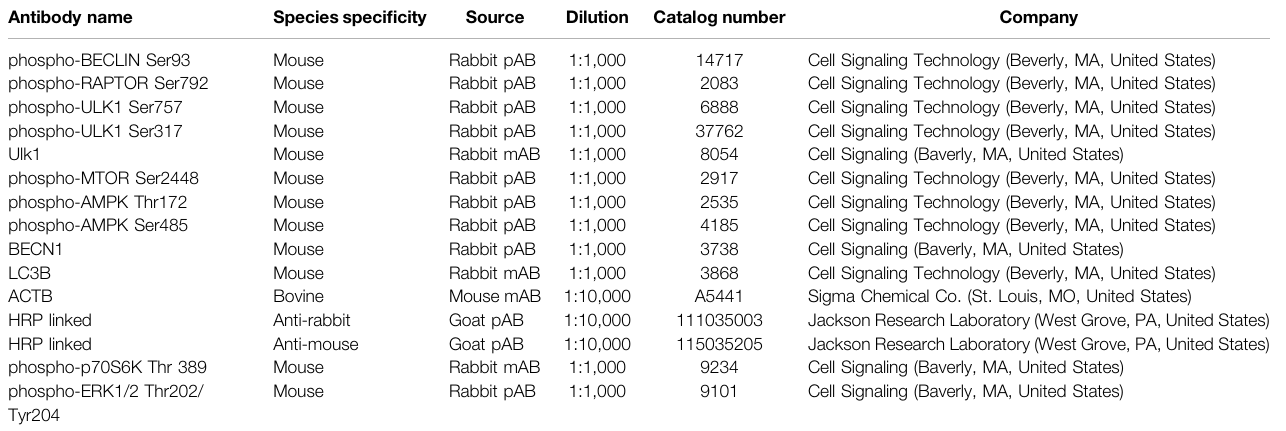
TABLE 1 | Antibodies Used in this